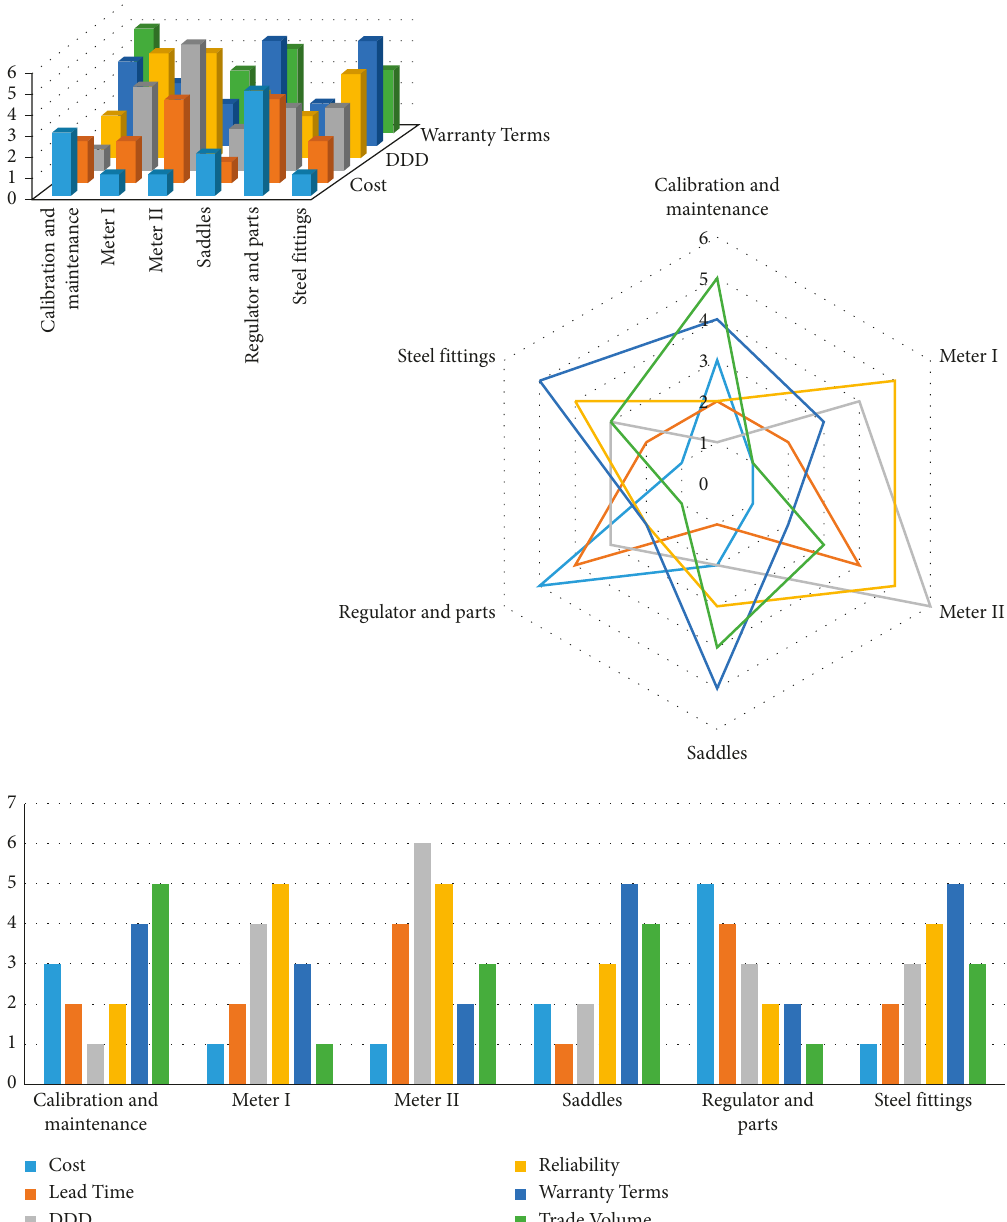
Figure 4: Influence of decision criteria according to different item